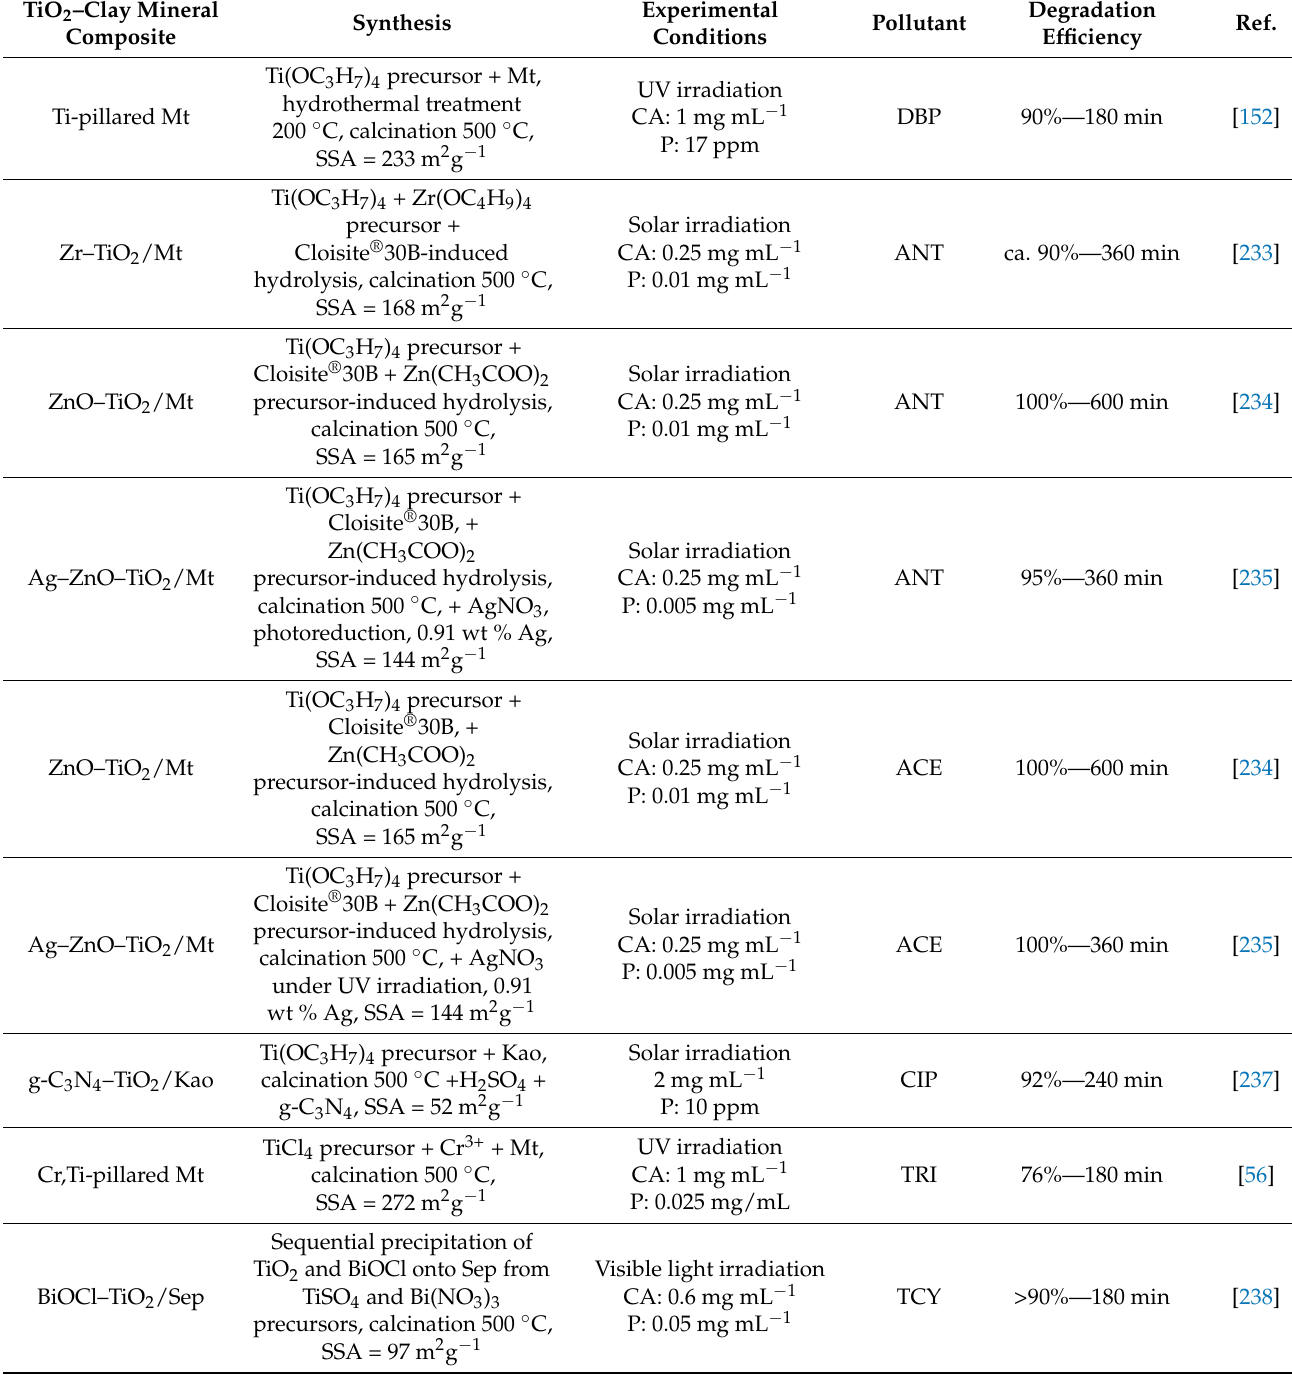
Table 7. Main synthesis and photocatalysis data for selected examples of TiO 2 composites with clay minerals used for the degradation of emerging pollutants (ALA—alachlor, ACE—acetaminophen, ANT—antipyrine, ATR—atrazine, BRO—bromacil, DBP—dibutyl phthalate, CHT—chlorotoluron, CIP—ciprofloxacin, DIM—dimethachlor, IMA—imazaquin, SUS—sulfosulfuron, TCY—tetracycline, TRI—trimethoprim, Kao—kaolinite, Lap—Laponite, Mt—montmorillonite, Sep— sepiolite, P—pollutant, CA—catalyst